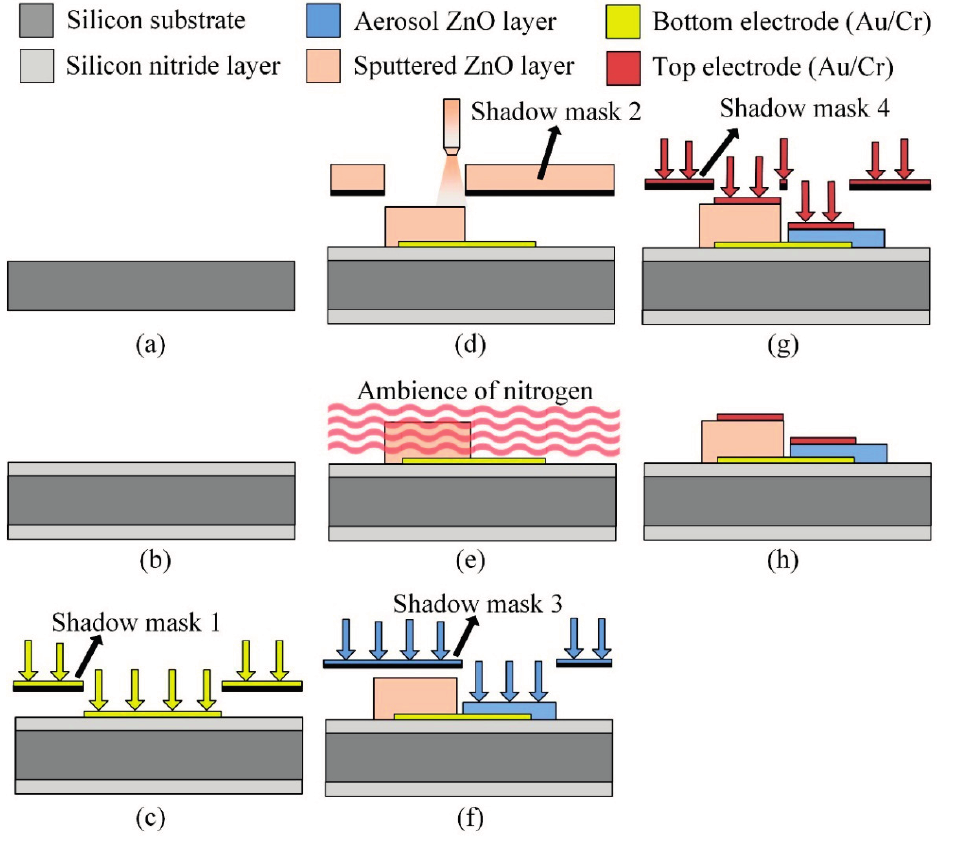
Figure 4. Fabrication flow for the multi-frequency band pyroelectric sensor.